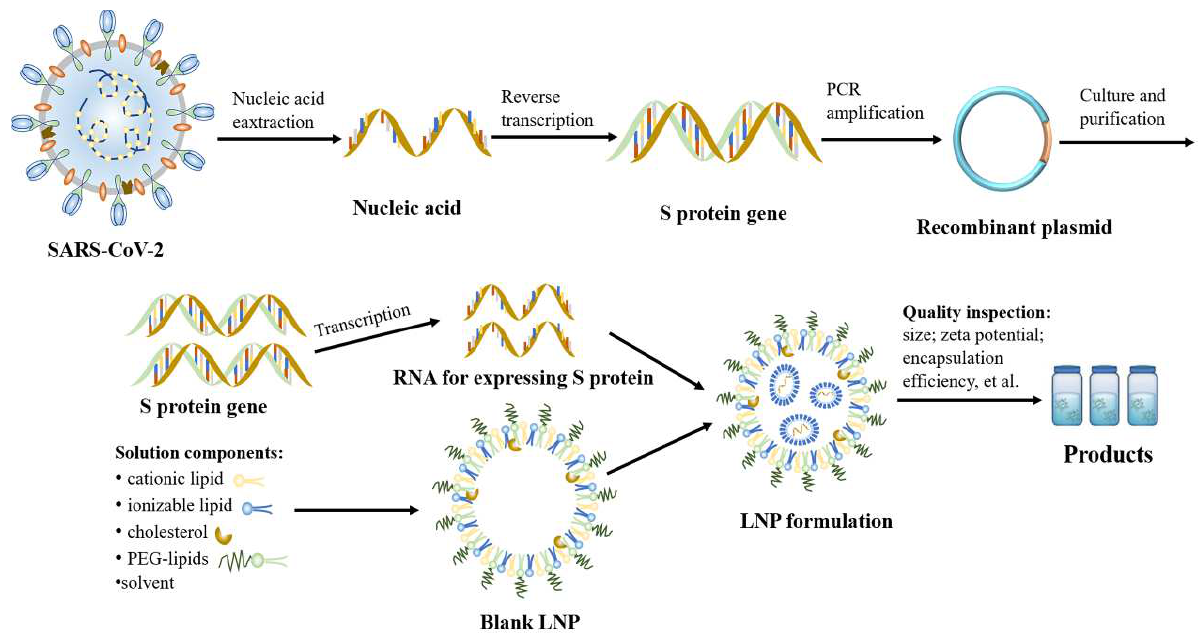
Figure 5. The workflow of mRNA–LNPs.